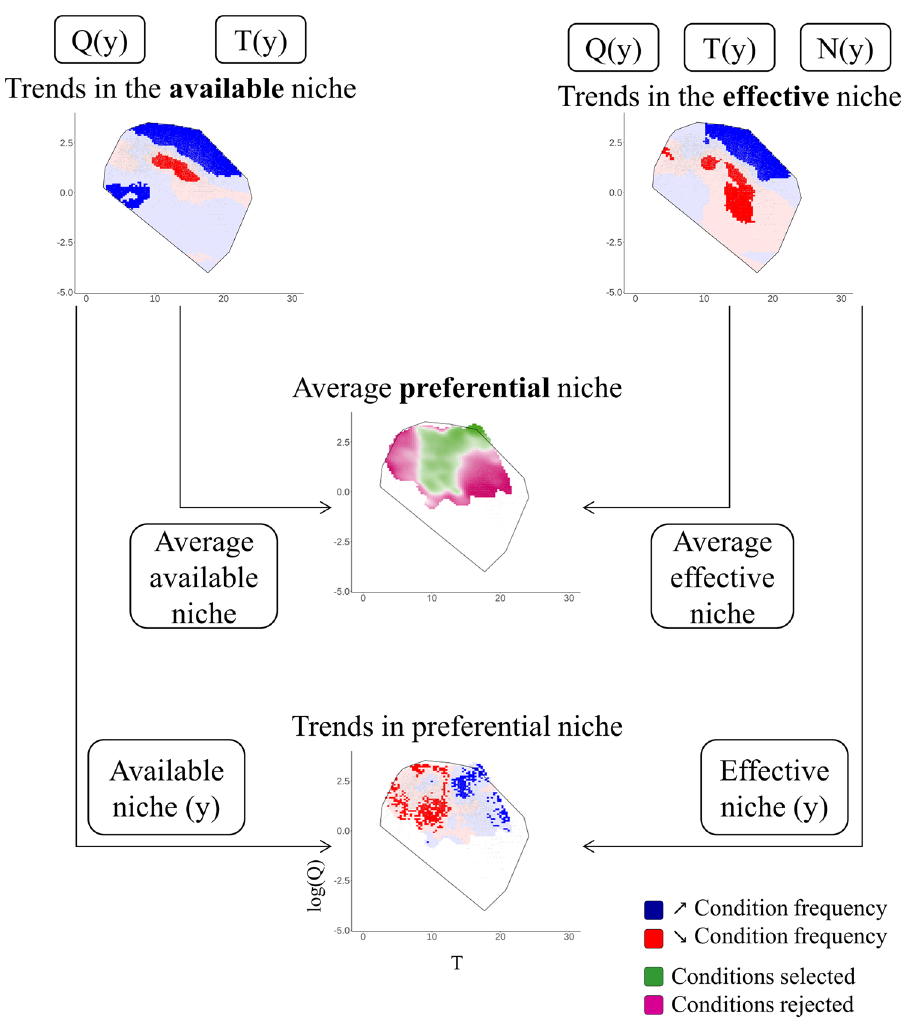
Figure 3. Schematic representation of the methodological framework and links between the performed analyses. Daily water temperature T and discharge Q are used to identify trends in the available niche over the years y . T and Q , weighted by the daily proportions of eel passage N , are then used to identify trends in the effective niche. The available and effective niches are finally used to calculate an average preferential niche over the study period and trends in the preferential niche over the years y